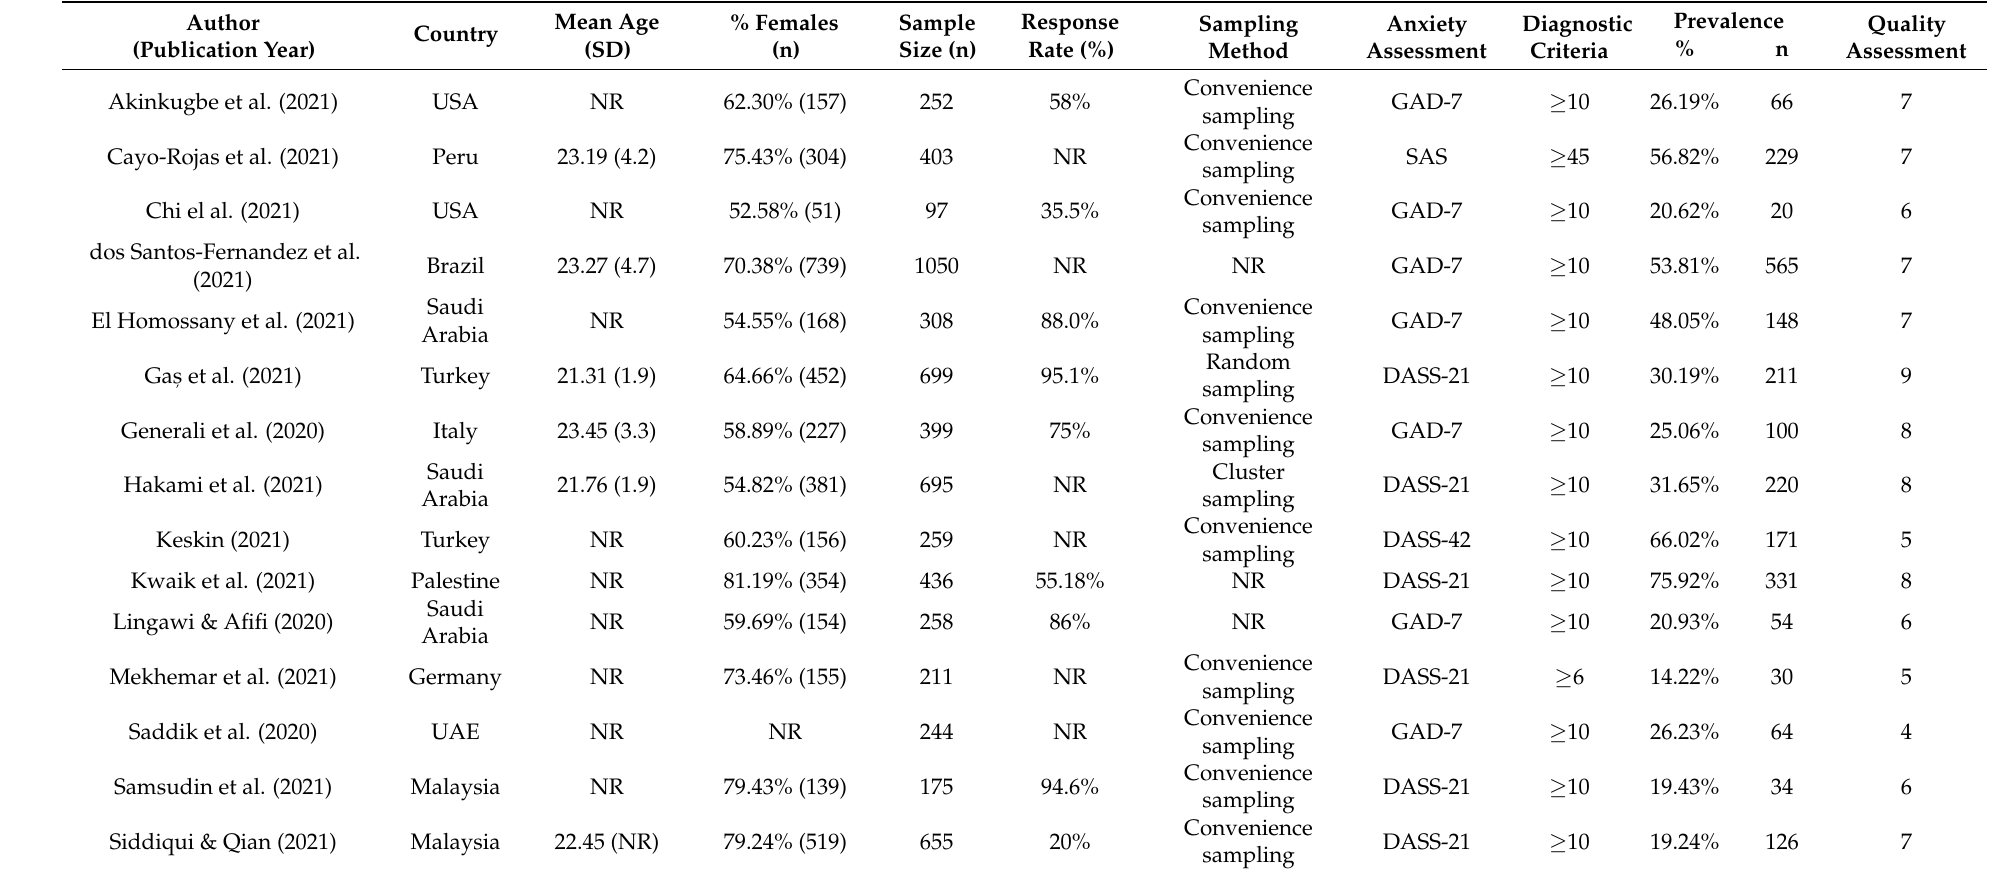
Table 2. Description of studies included in the